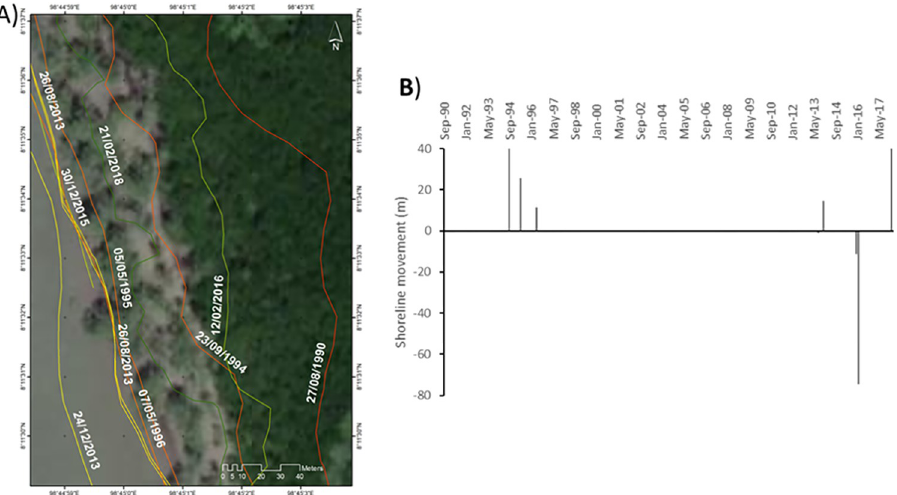
Fig 10. Representations of the shoreline movements observed during the survey period in site 5. A) Visualisation of the shoreline positions for the highest water level marks digitised with CoastSat. B) Shoreline movements measured using DSAS between two consecutives chronologically ordered digitised shorelines; negative values correspond to erosion and positive values to accretion. Basemap satellite images accessed from World Imagery ESRI Tile Layer. Credits: Esri, Maxar, GeoEye, Earthstar Geographics, CNES/Airbus DS, USDA, USGS, AeroGRID, IGN, and the GIS User Community.